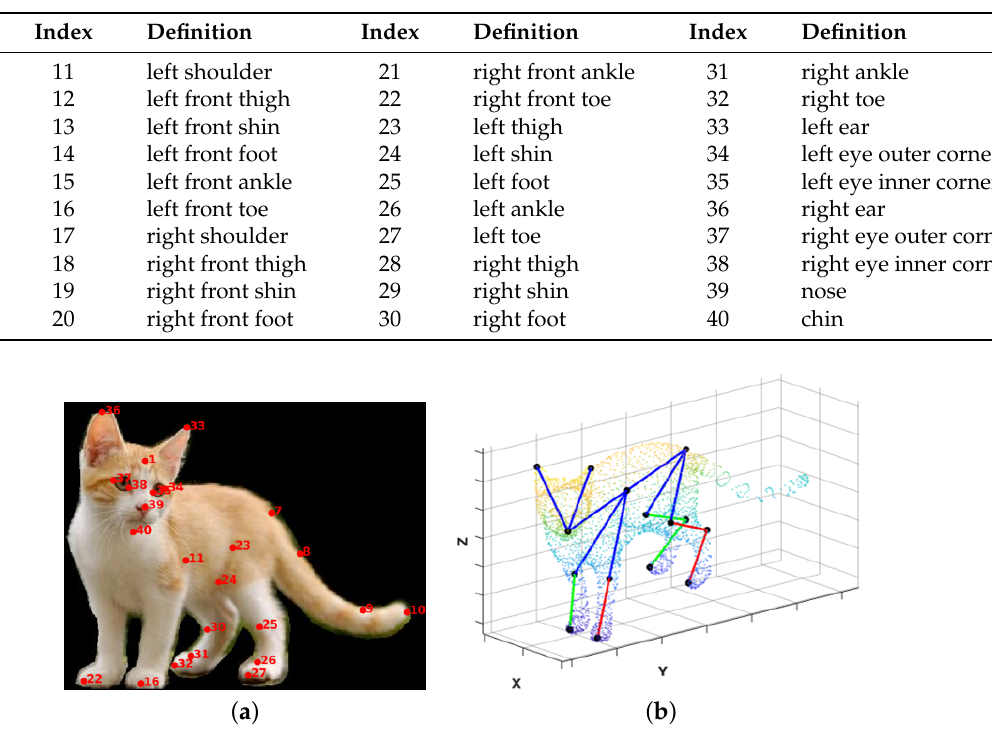
Figure 2. Examples in the proposed dataset Cat. Each red point marks a key point. The number represents the index of the key point, as shown in Table 1. Table 1. Definition of key points in the proposed dataset, Cat.